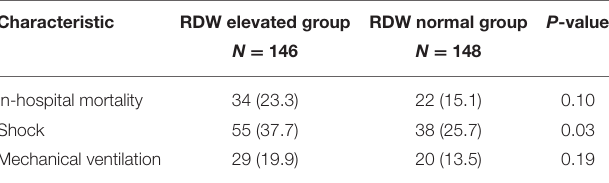
TABLE 3 | Outcomes data on hospitalized COVID-19 patients according to their red blood cell distribution width (RDW) value.